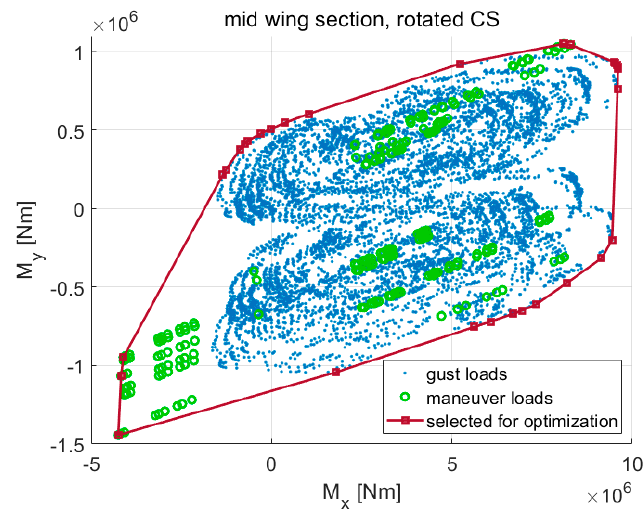
Figure 10. 2D envelope surrounding gust and maneuver